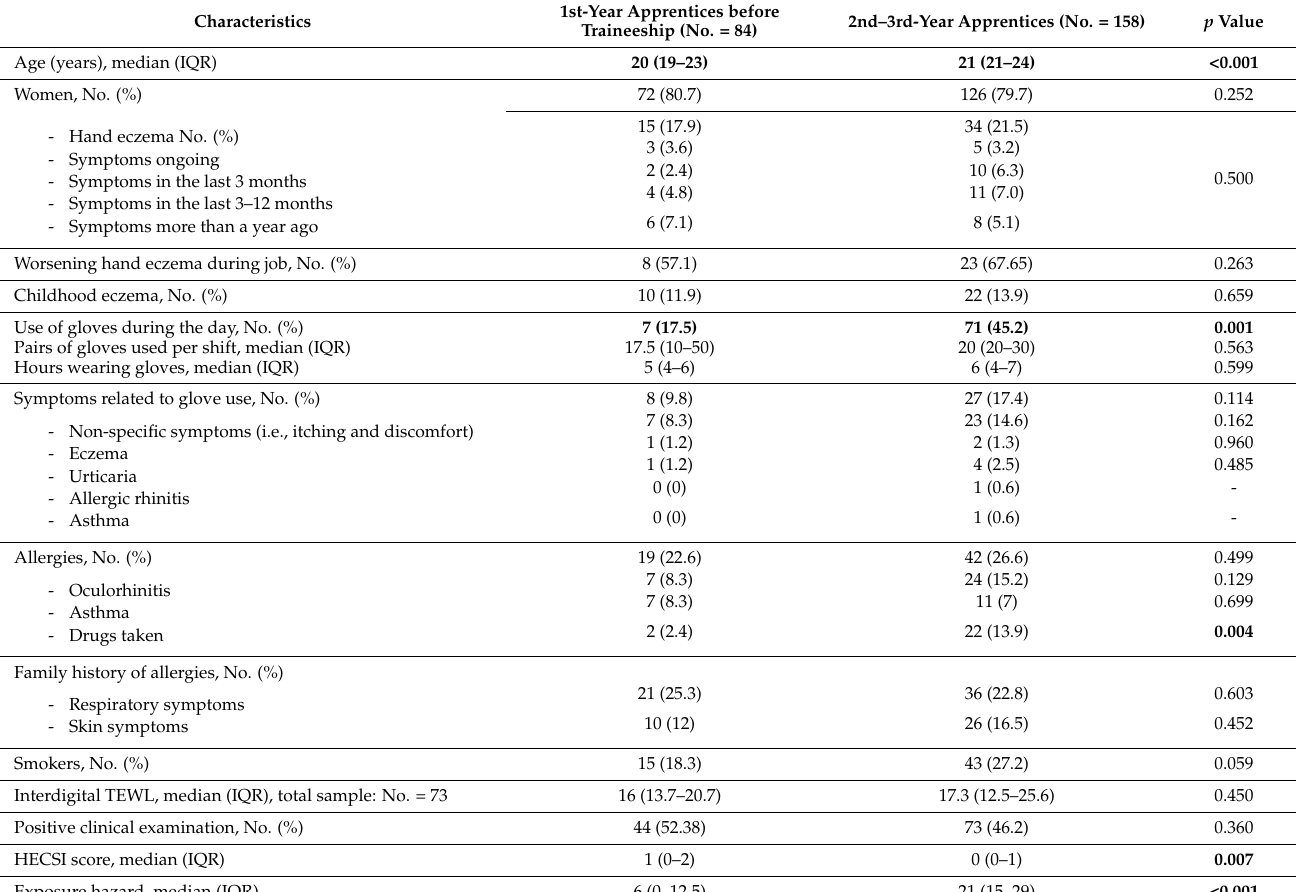
Table 1. Characteristics of apprentice nurses studied. In bold are reported significant